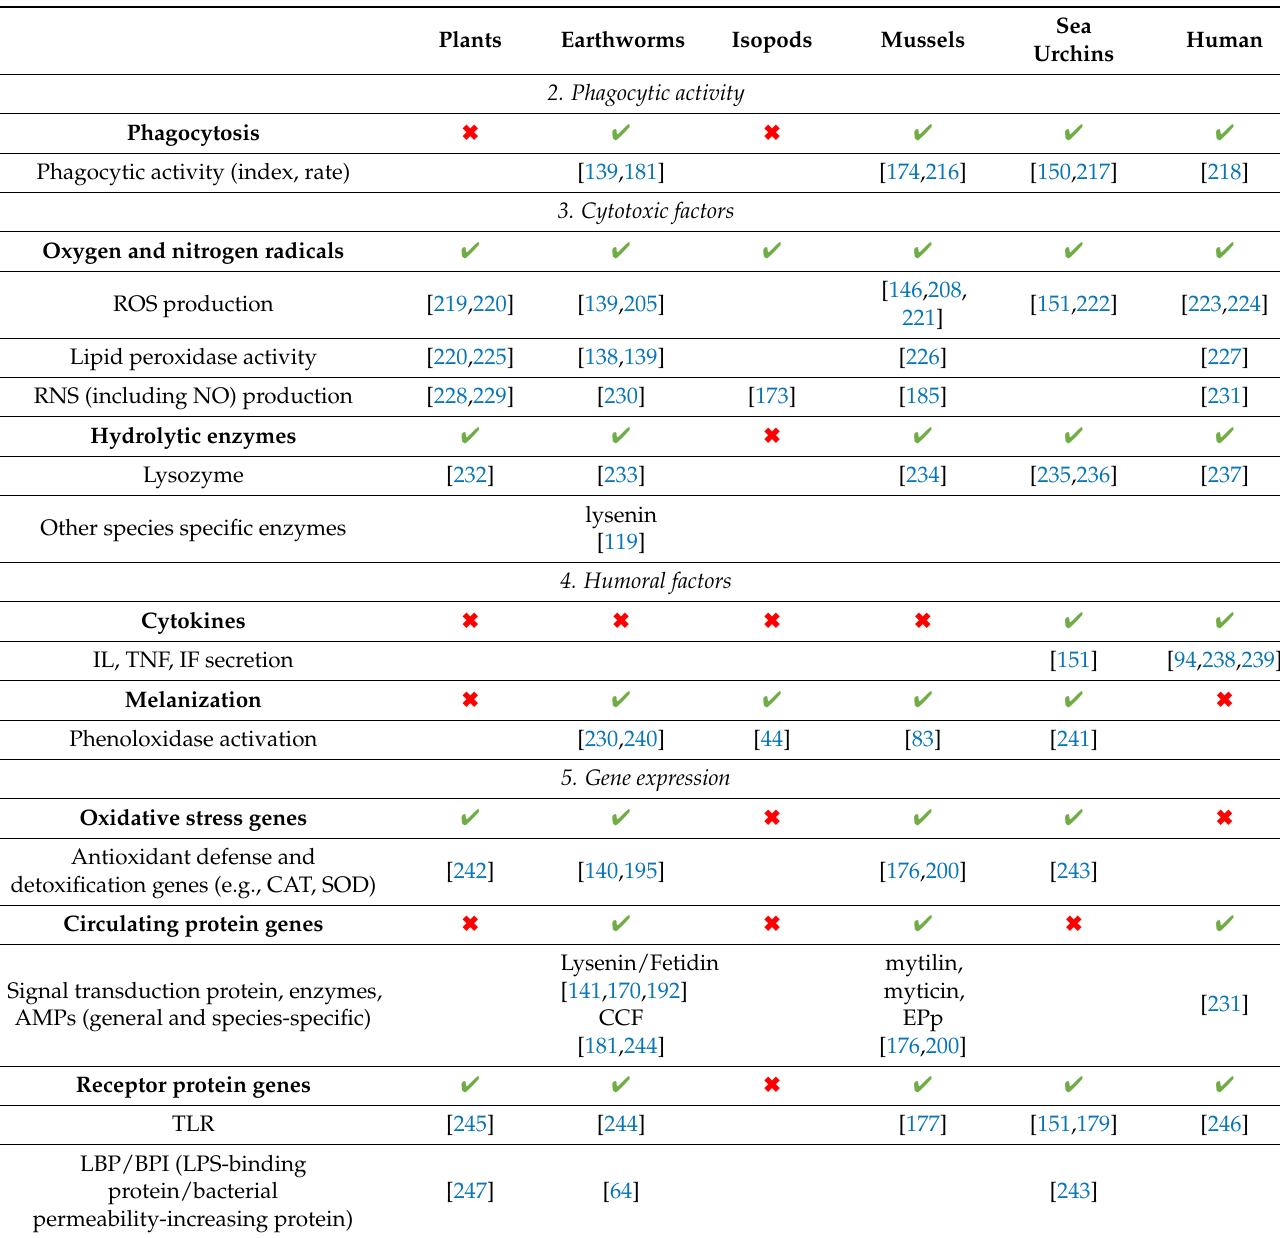
Sea Human Urchins